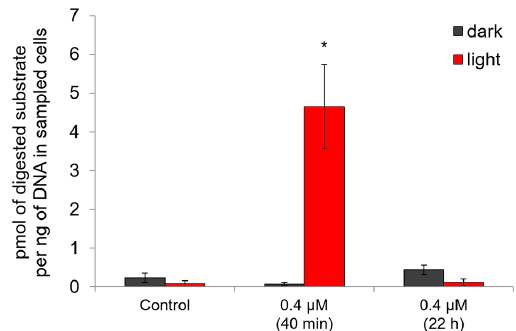
Figure 7. Caspase-3 activity in HeLa cells after treatment with Compound 21 in the dark (40 min and 22 h) and with photoactivation (2 h in the dark followed by 20 min under red light and then again 40 min or 22 h in the dark). The data were normalized according to the DNA content in the corresponding samples. The average values of the six experimental repeats are shown in the figure.